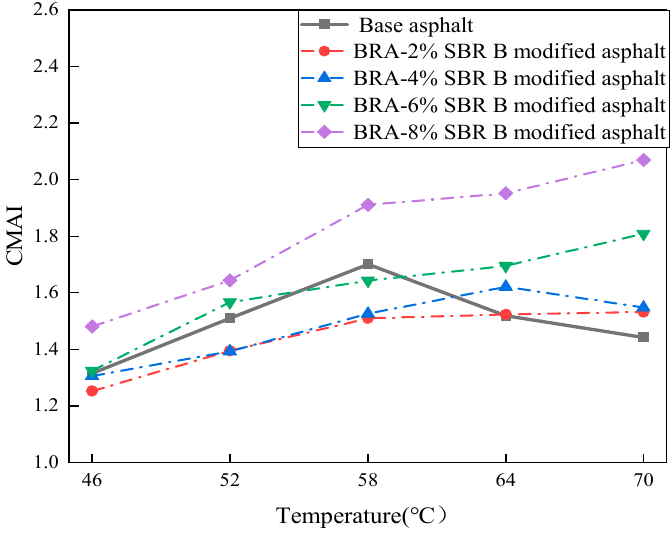
Figure 7. CMAI of base asphalt and BRA-SBR B modified asphalt.